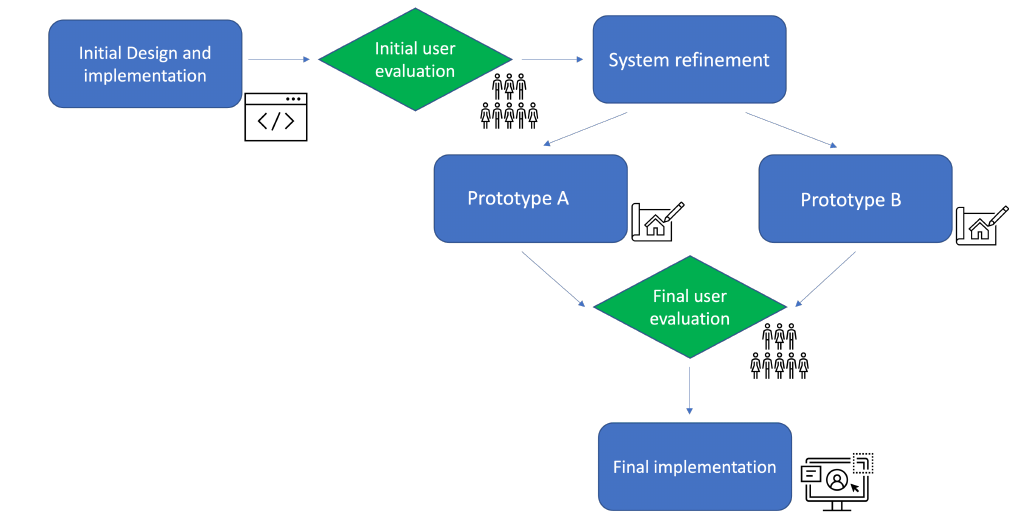
Figure 3. A flowchart showing the stages of the adopted